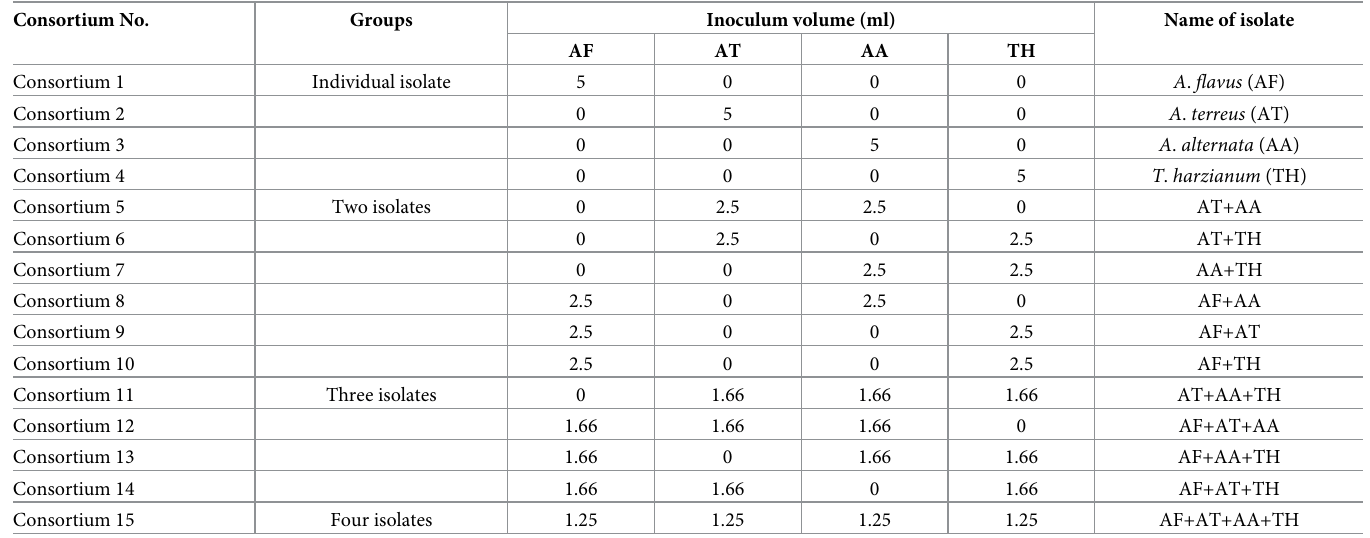
Table 1. Number of consortia and groups of isolates. Consortium